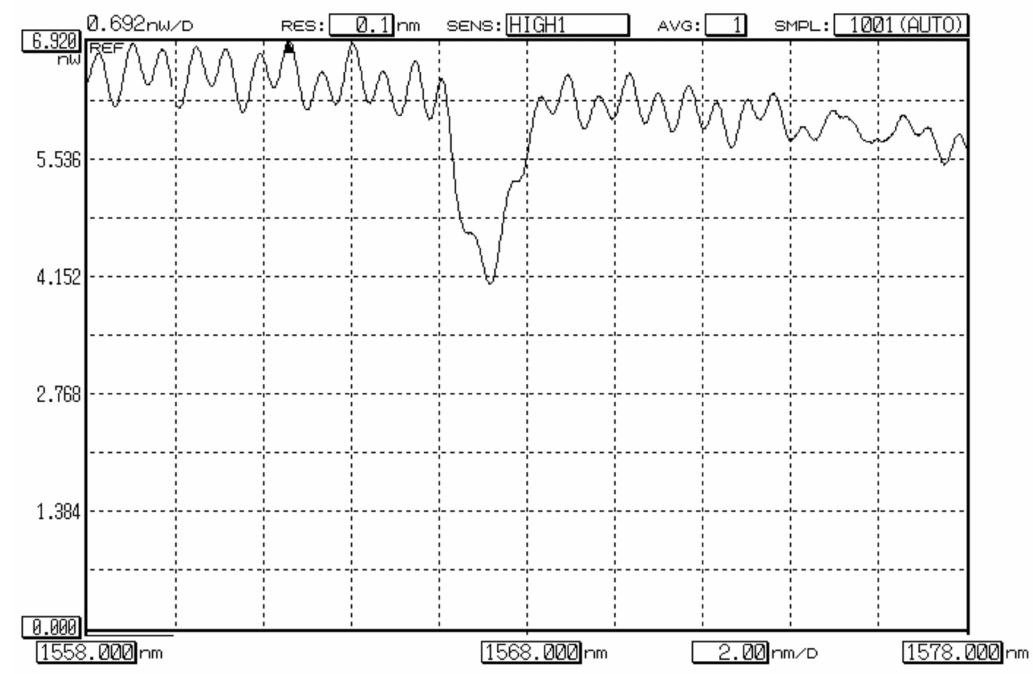
Figure 13. Reference spectral response of unperturbed FBG, written on FMF